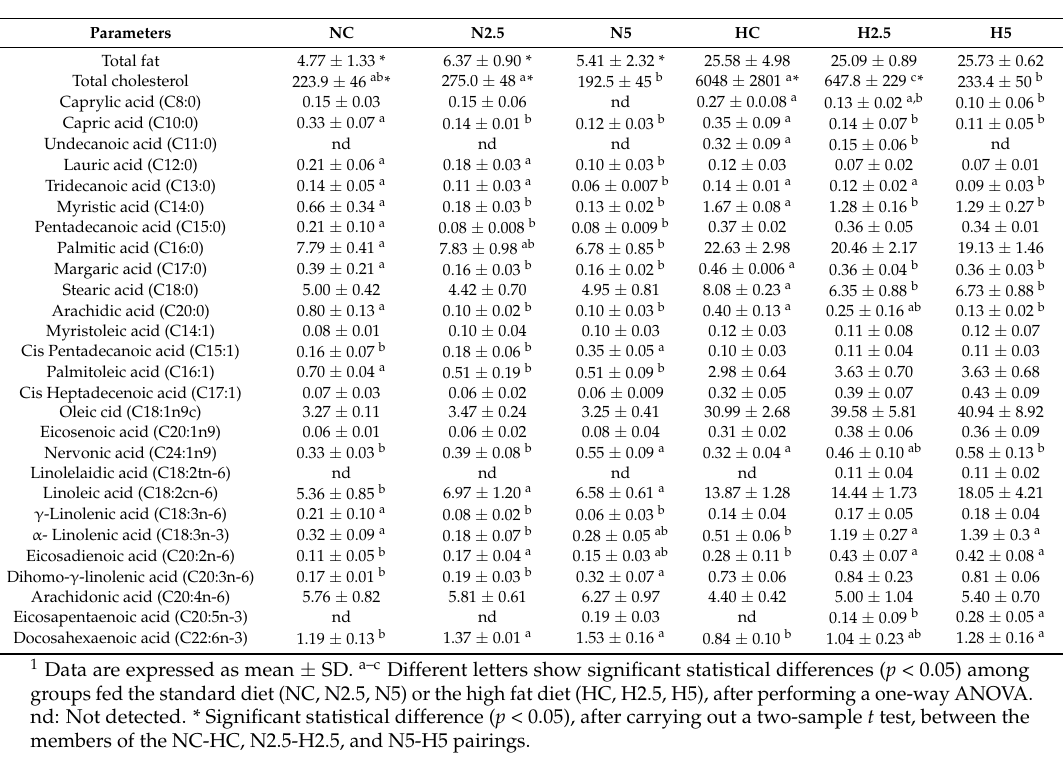
Table 5. Total fat (mg/100 g), cholesterol content (mg/g) and fatty acid concentrations (mg/g) in the liver of rats in the six experimental groups at the end of the 5-week intervention period 1 . Parameters